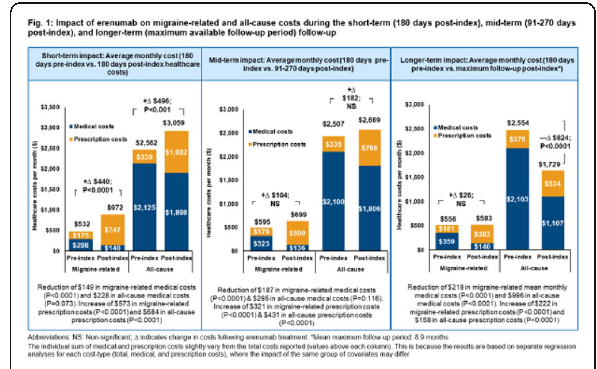
Fig. 1 (abstract AL050). See text for description